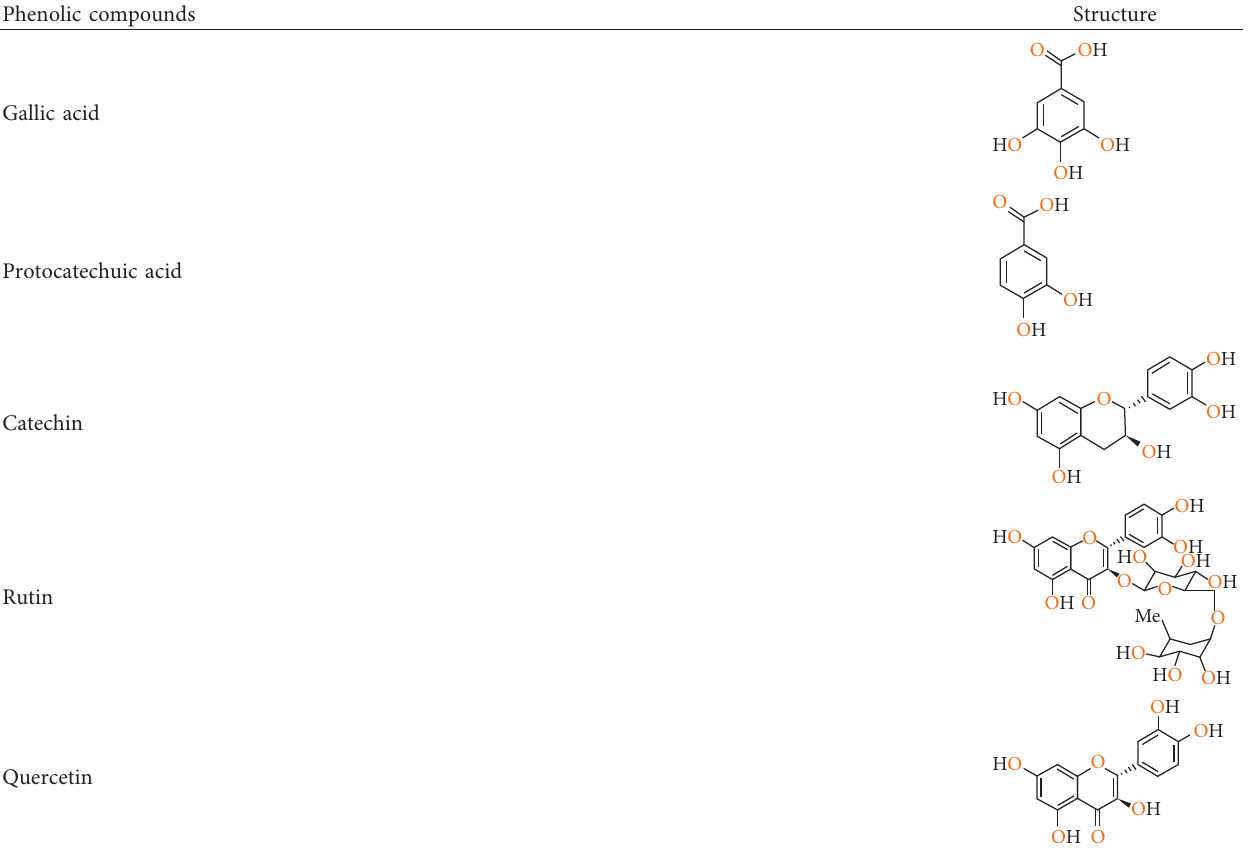
Table 6: Structure of phenolic compounds identified in Pistacia vera L.